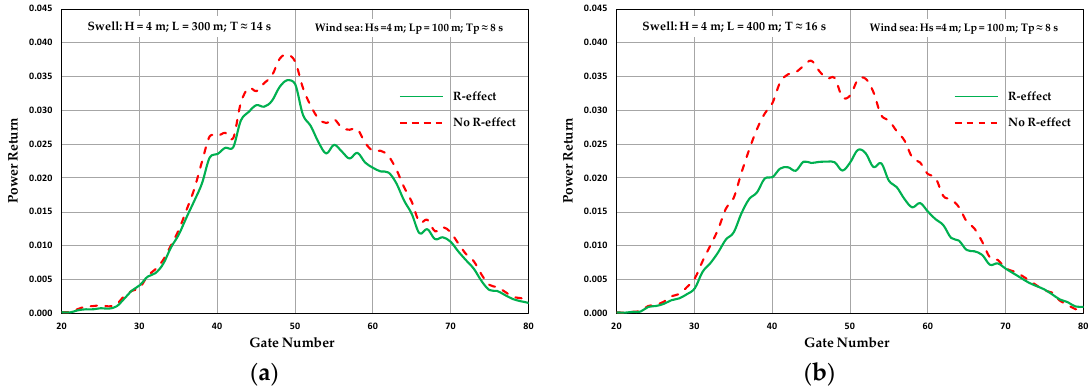
Figure 9. Simulated single waveforms with (solid green line), and without (dashed red line), R-effect for swell superimposed to a wind sea: ( a ) JONSWAP significant wave height Hs = 4 m, peak wave period Tp = 8 s; swell wave height H = 4 m, period T = 14 s; ( b ) JONSWAP significant wave height Hs = 4 m, peak wave period Tp = 8 s; swell wave height H = 4 m, period T = 16 s. When average 20 Hz WFs are compared, a consistent difference is evident, the R-WF being less steep (Figure 10) in the leading edge. J. Mar. Sci. Eng. 2020 , 8 , x FOR PEER REVIEW